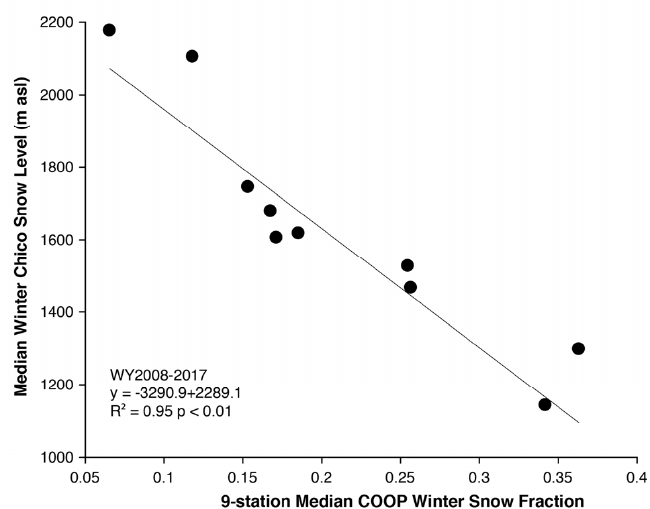
Figure 4. Scatterplot of winter median Chico observed winter snow levels versus winter median National Weather Service Cooperative Observer (COOP) snow fractions between WY2008 and 2017.